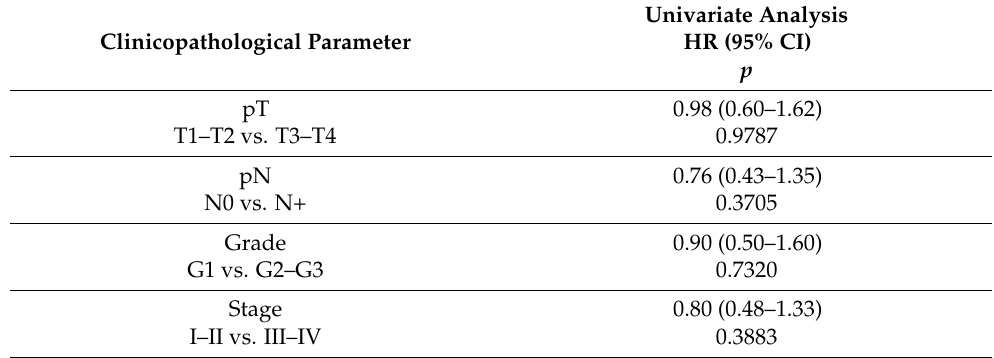
Table 4. Univariate and multivariate Cox proportional hazards analyses in 140 patients with